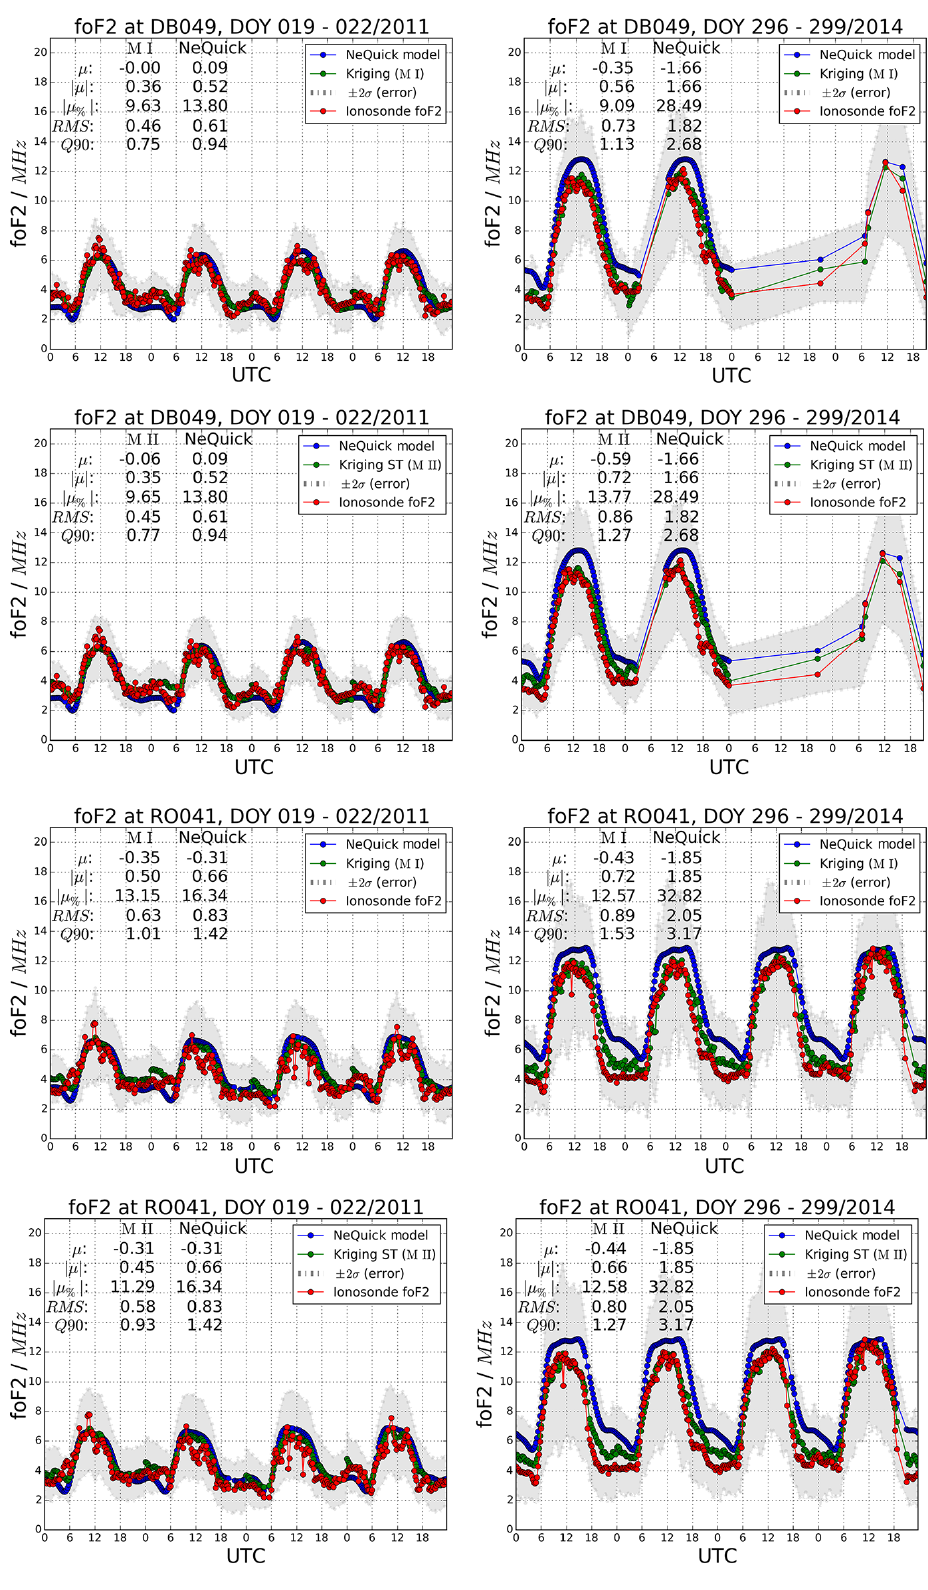
Figure 5. Comparison of fo F2 estimated by the NeQuick model (blue), the kriging with spatial covariance MI (green, upper row) and the kriging with spatial–temporal covariance MII (green, lower row) at the ionosonde station locations of DB049 and RO041 for both